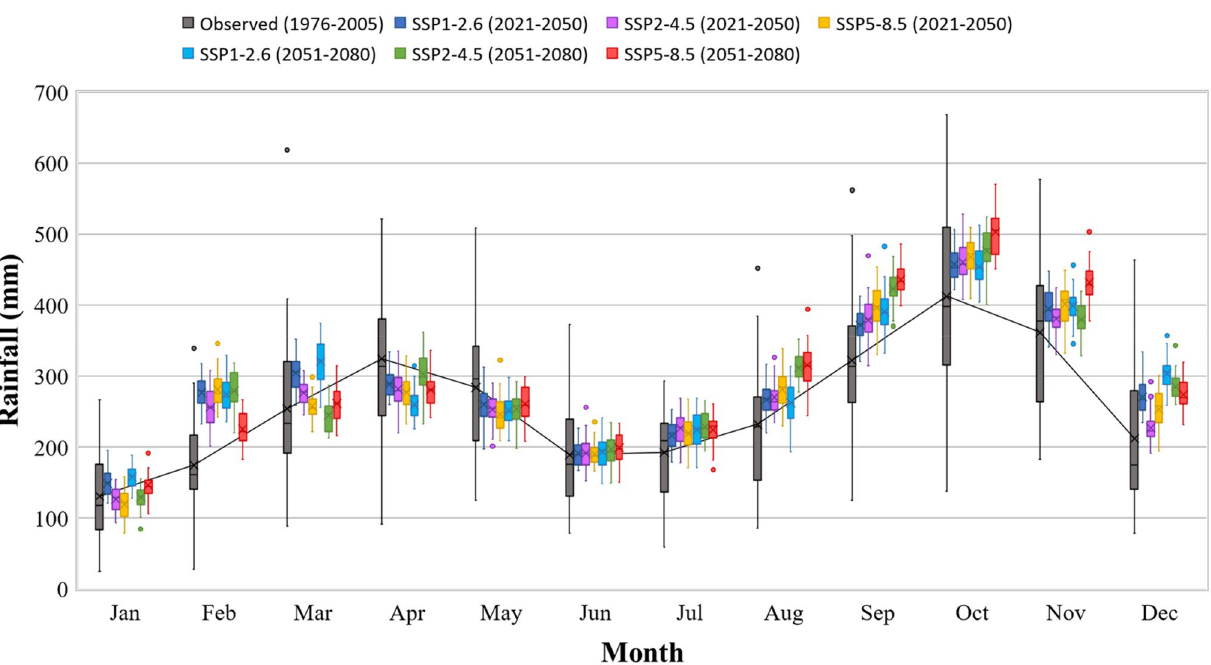
Fig. 6 Projected ensemble mean monthly rainfalls under SSP1-2.6, SSP2-4.5, and SSP5-8.5 scenarios for future periods 2021–2050 and 2051–2080 and with respect to baseline period of 1976–2005 with mean of baseline values (line)